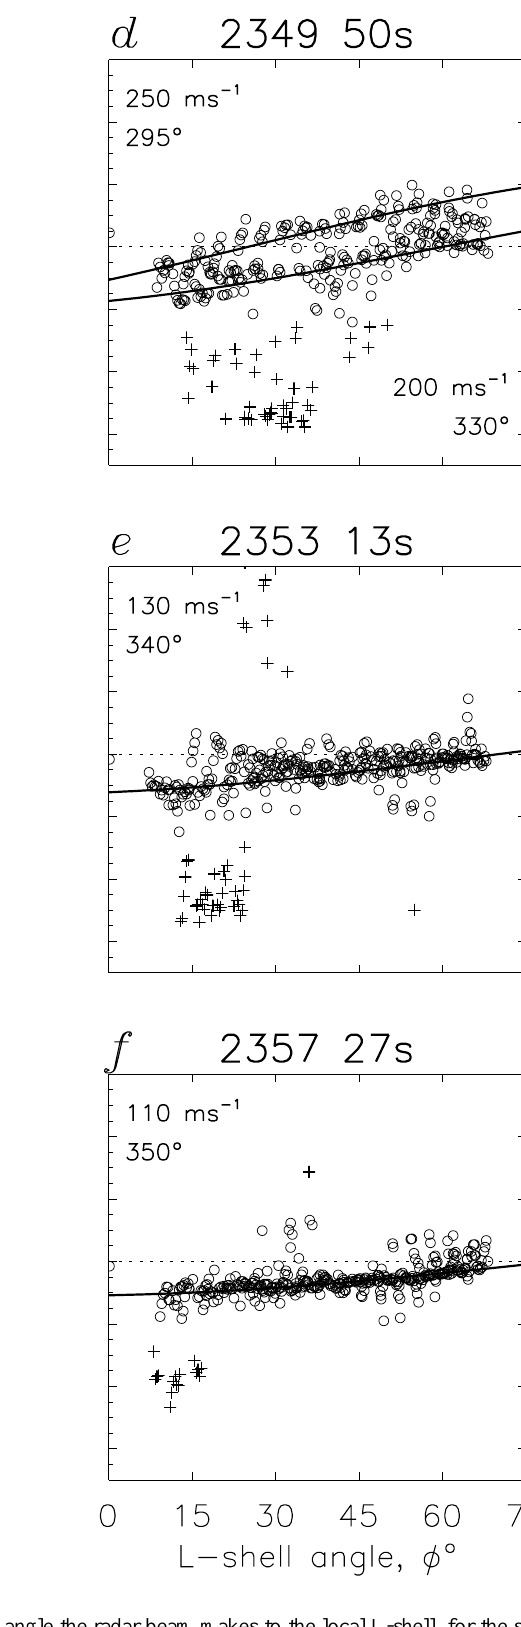
Fig. 6. Line-of-sight Doppler velocity as a function of L-shell angle, the angle the radar beam makes to the local L-shell, for the six scans presented in Figs. 4 and 5. Points are represented by circles or crosses depending on whether the Doppler velocity is less than or greater than 250 m s − 1 . Cosine-dependence fits to some of the populations observed have been superimposed, the constants parameterising these fits being indicated in the top-left or bottom-right of the